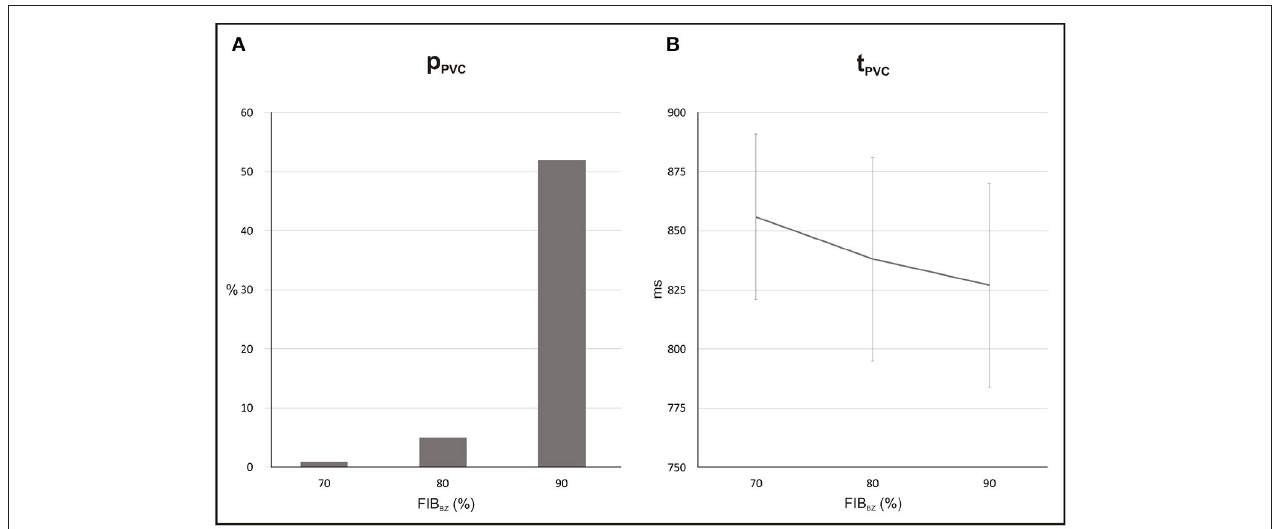
FIGURE 12 | Statistics of PVCs in the BiV model with different degree of fibrosis in the BZ ( FIB BZ ). (A) Probability p PVC of SCR-mediated PVCs. (B) Average waiting time t PVC